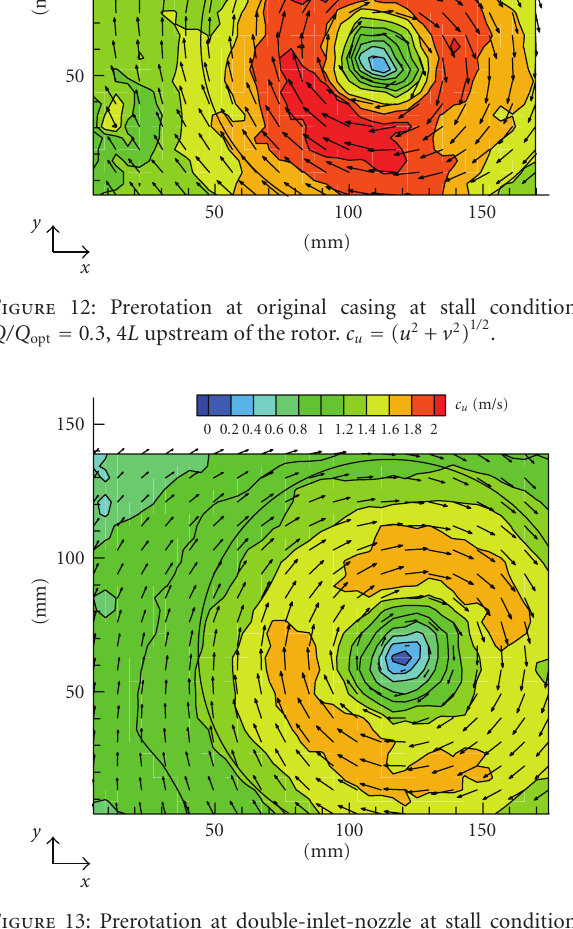
Figure 13: Prerotation at double-inlet-nozzle at stall conditions, Q/Q opt = 0 . 3, 4 L upstream of the rotor. c u = ( u 2 + v 2 ) 1 / 2